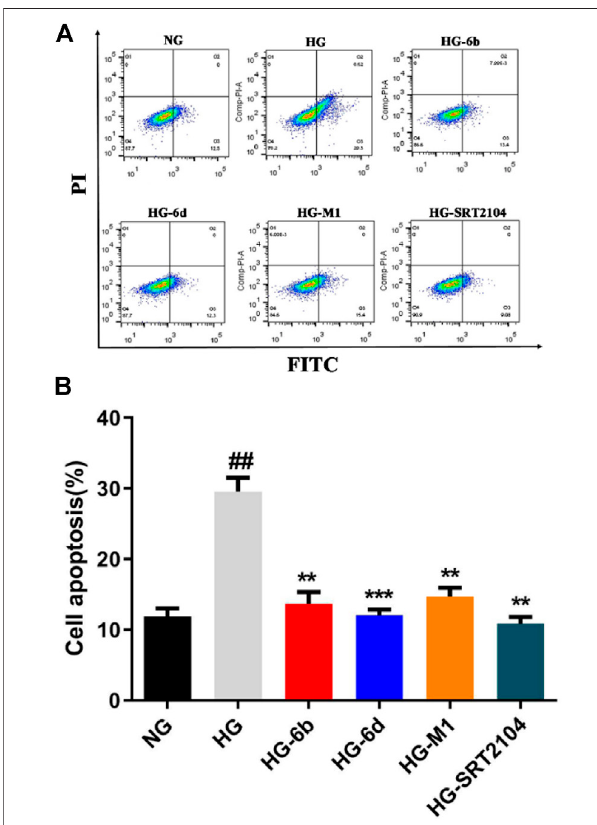
FIGURE 6 | Effect of compounds (10 μ M) on HG induced HK-2 cells apoptosis detected by fl ow cytometry. # High glucose (HG) group compared with Normal glucose (NG) group, *Dosing group compared to HG group, **/ ## p < 0.01, *** p < 0.001.